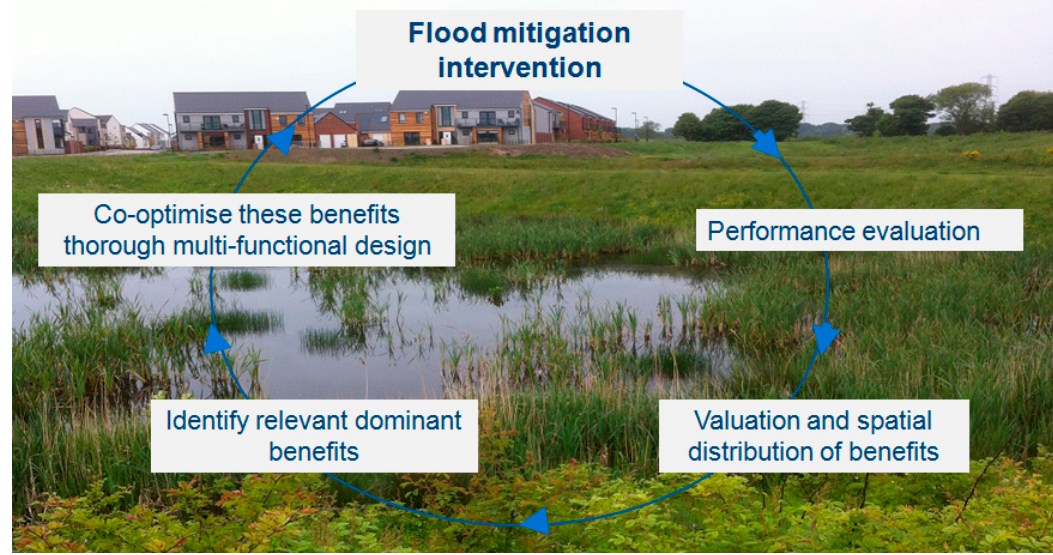
Figure 1. A positive feedback loop to reinforce multi-functional design of relevant dominant benefits in urban drainage systems that incorporate elements of green infrastructure’s (SuDS/GI).